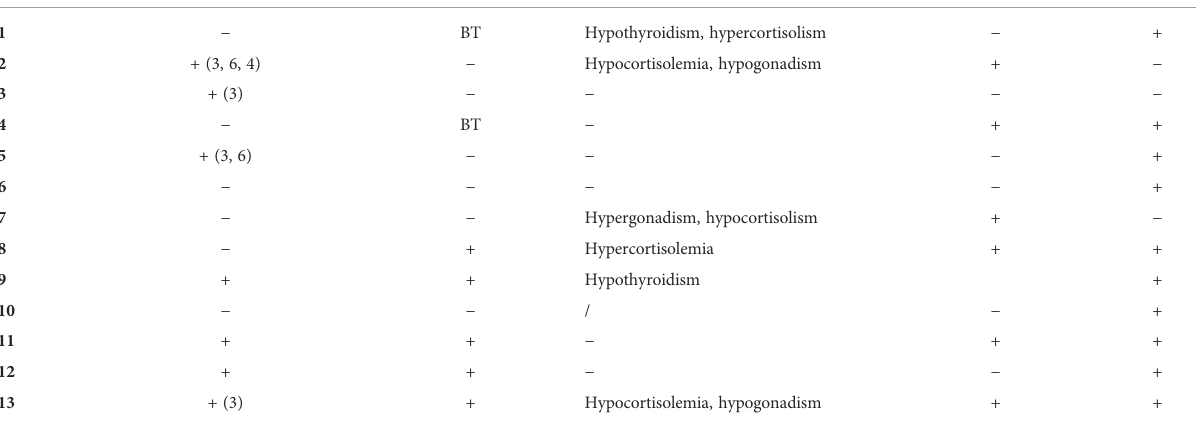
TABLE 2 Symptoms at